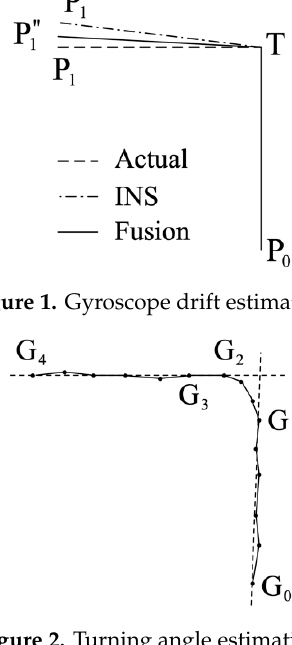
Figure 2. Turning angle estimation.